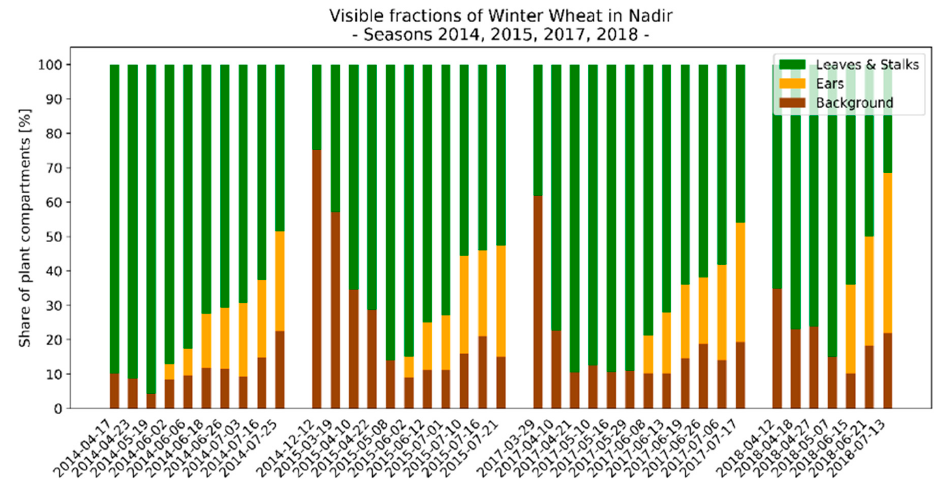
Figure 11. Seasonal development of plant fractions of winter wheat canopies as they become visible to a sensor that is observing the respective field in nadir view, obtained from nadir RGB image segmentation for four seasons (2014, 2015, 2017, 2018).